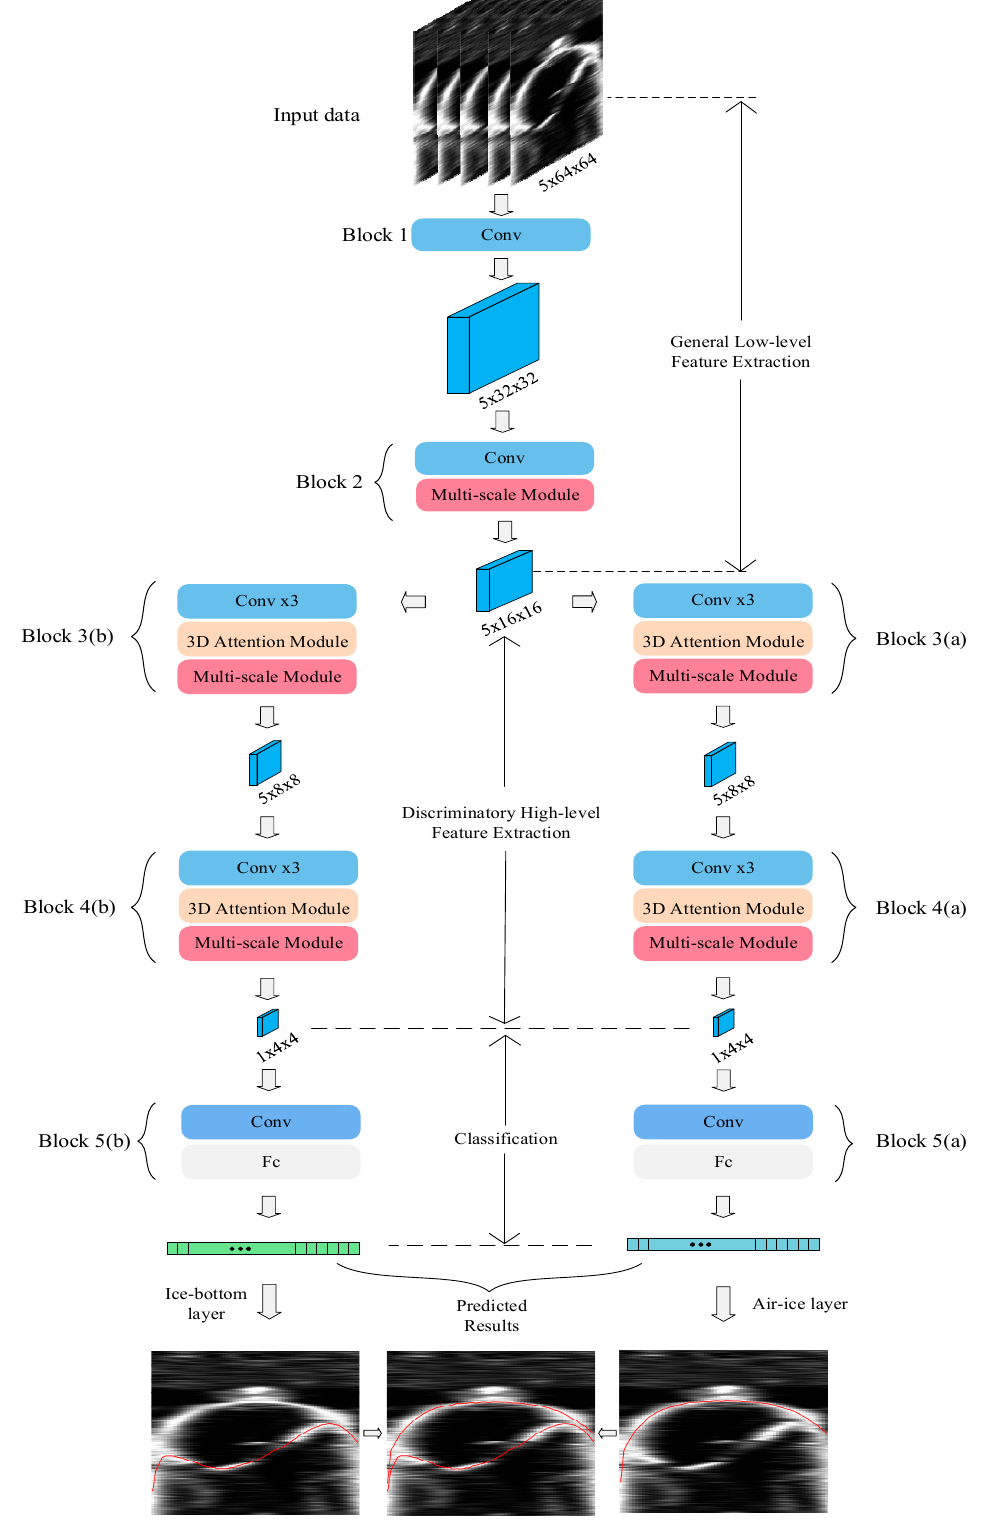
Figure 5. The whole framework of the MsANet. The MsANet, which is divided into 5 blocks, consists of improved C3D-M inserted with proposed Msks and 3D attention modules. The blue cuboid is the feature maps with a size of A × B × C (depth × width × height); for example, the first one after block 1 is the feature maps with a size of 5 × 32 × 32. The MsANet contains five types of blocks. After sequential slices are fed into the MsANet, the general low-level features of two layers are learned in shallow block 1 and